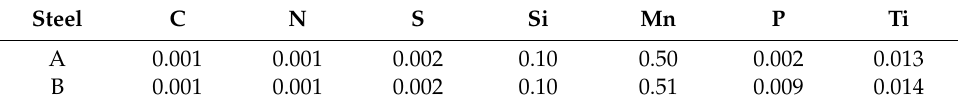
Table 1. The compositions of the interstitial-free (IF) steels